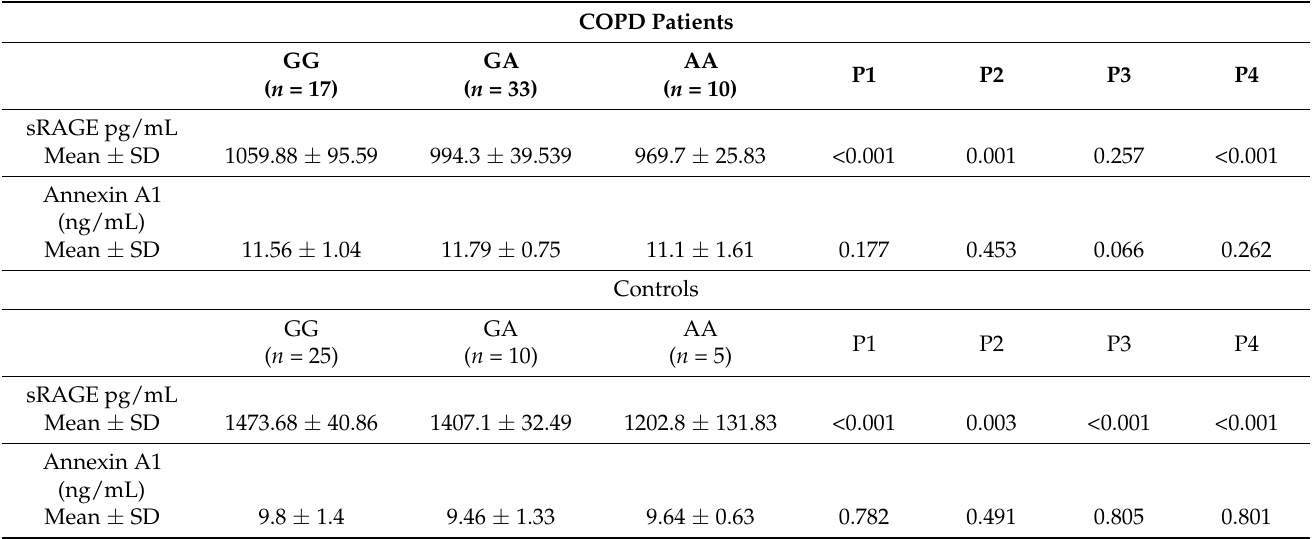
Table 6. Serum levels of sRAGE in COPD patients and controls according to RAGE rs2070600 poly- morphism. COPD